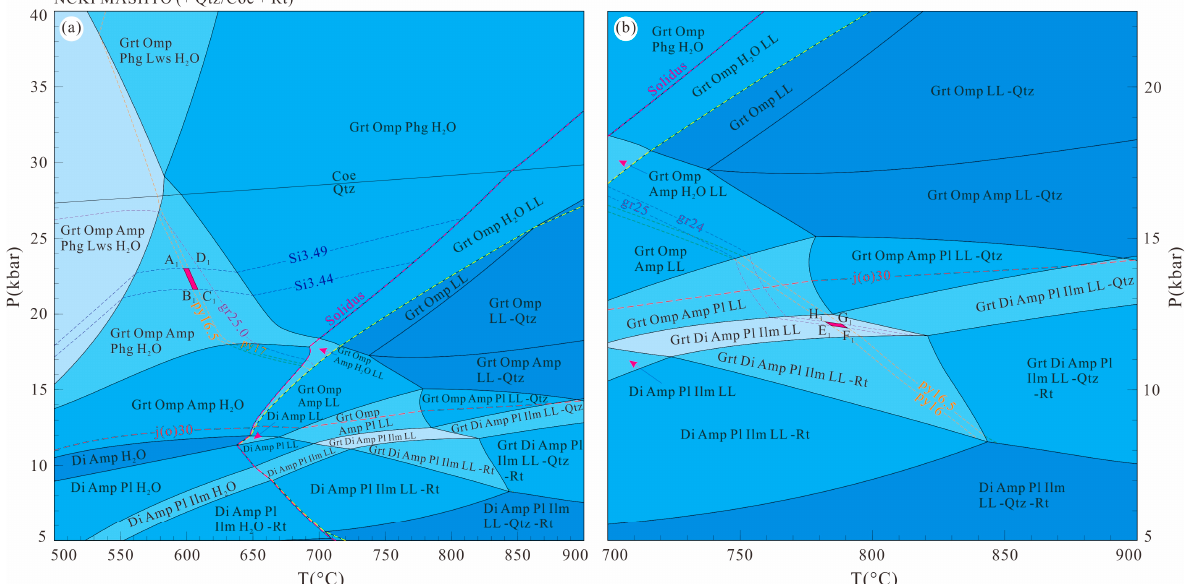
Figure 7. ( a ) P-T pseudosection for sample G-10 calculated with the bulk-rock composition. ( b ) P-T pseudosection for sample G-10 calculated with an effective bulk composition generated according to mass-balance constraints from garnet rim and other relevant minerals. The pseudosection is contoured with isopleths of X gr (i.e., gr25 is X gr = 0.25 in Grt) and X py (i.e., py17 is X py = 0.17 in Grt) of garnet and Si contents in phengite (i.e., Si3.44 is Si = 3.44 p.f.u. in Phg). The location of the boundary between omphacite and diopside is defined on the basis of j(o) = 0.30 [45]. The mineral abbreviations are as follows: Lws = lawsonite; Di = diopside; LL = melt; “-Qtz/Coe”, denotes quartz/coesite -absent assemblages. The compositions used for modelling are listed in Table 1. Other details are the same as Figure